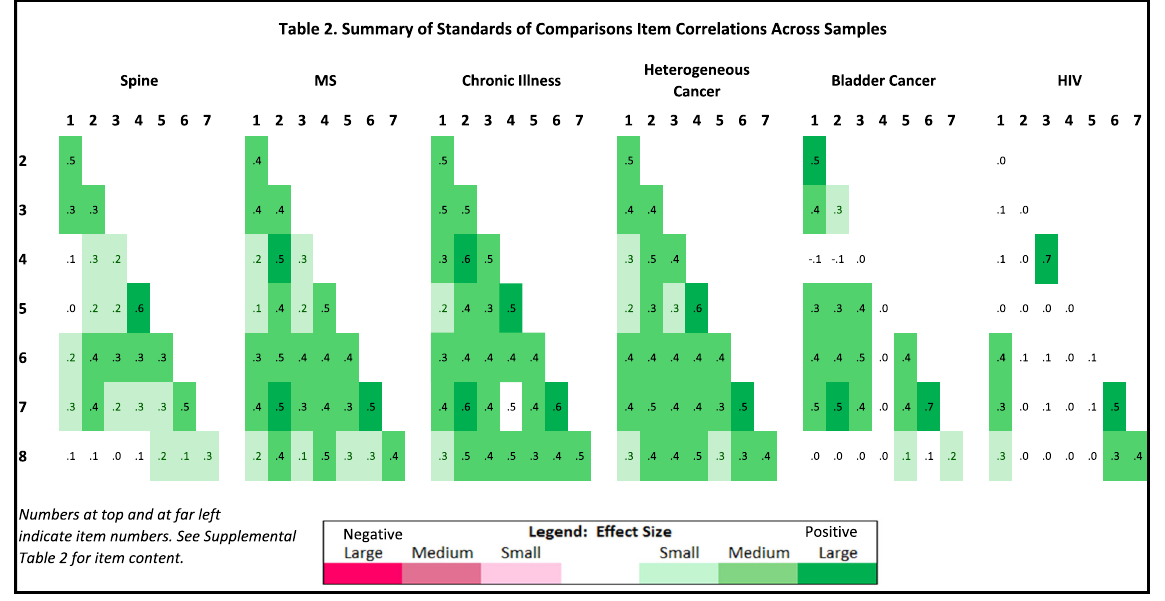
Table 2 Summary of Standards of Comparisons item correlations across